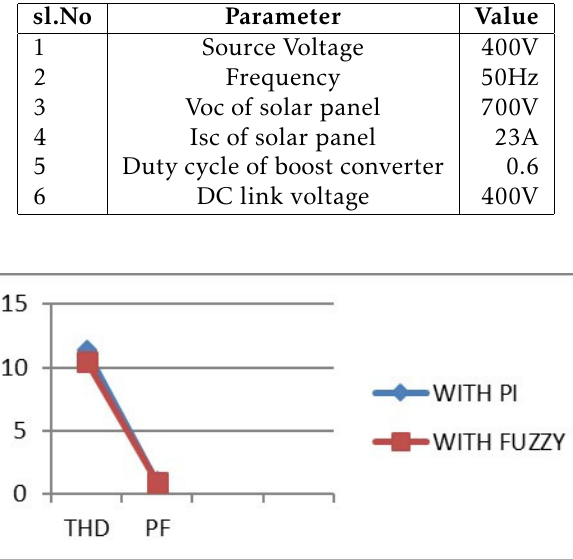
Figure 21. Comparision graph of PI and fuzzy